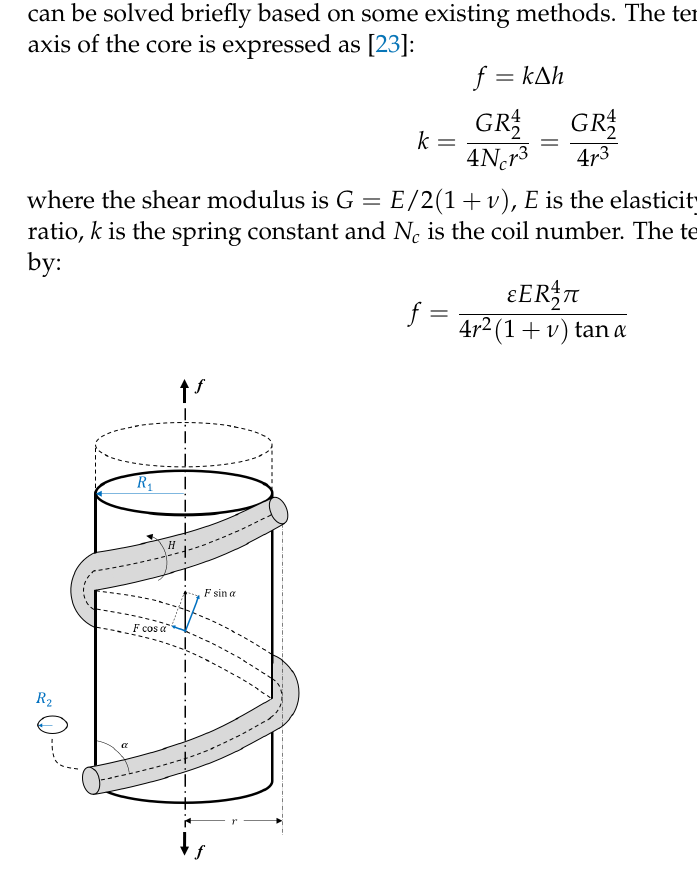
Figure 4. Schematic diagram of spring parameters.